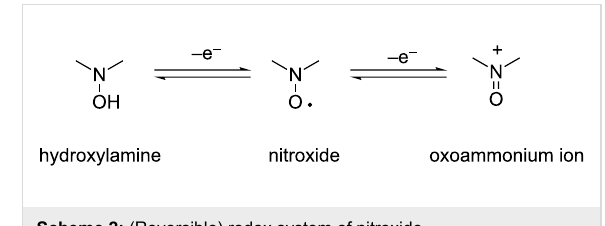
Scheme 2: (Reversible) redox system of nitroxide.